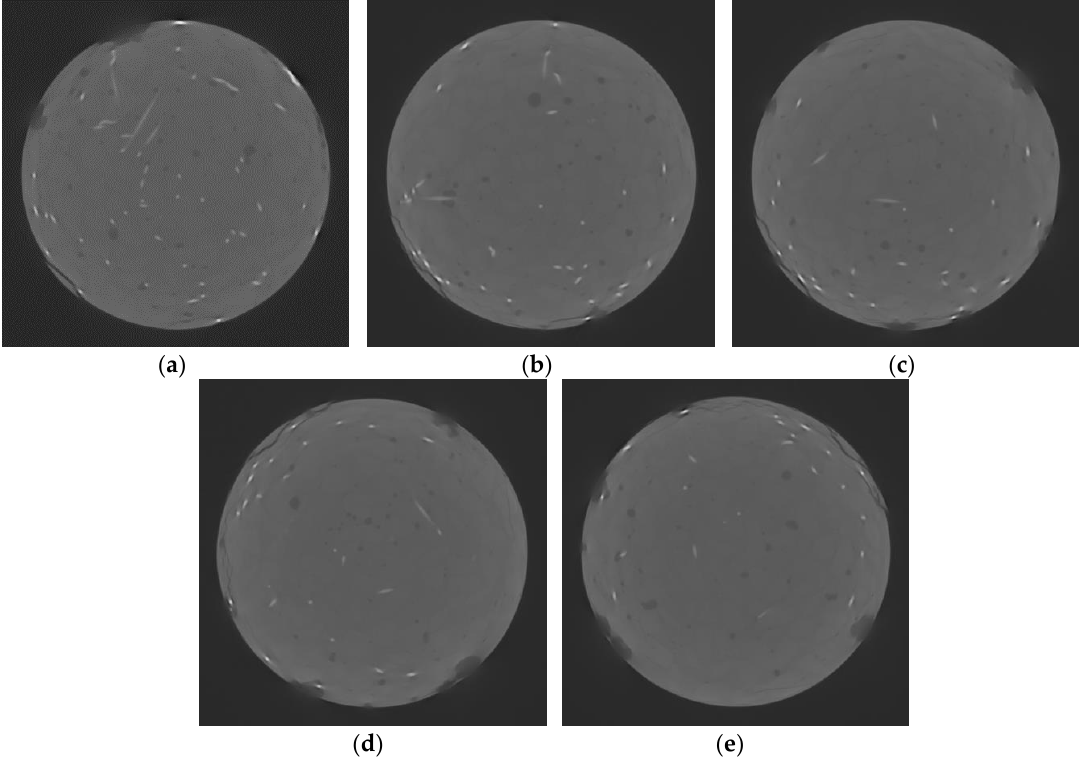
Figure 15. Examples of cracking in specimens of SFHPC. L-Series under the five different sets of cycles: ( a ) 0 cycles; ( b ) 2000 cycles; ( c ) 20,000 cycles; ( d ) 200,000 cycles; ( e ) 2,000,000 cycles.